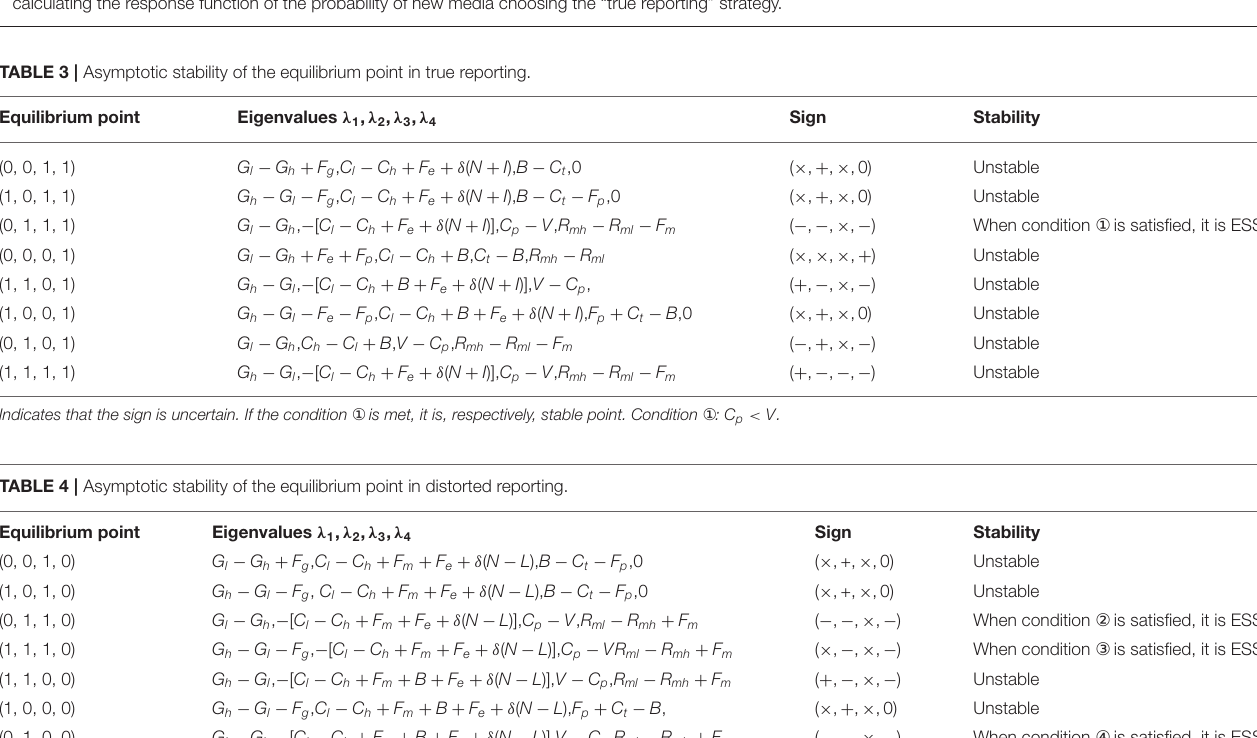
FIGURE 5 | Phase diagram of new media strategic choice. Figure is the phase diagram that shows the evolutionary trend of new media’s strategy obtained by calculating the response function of the probability of new media choosing the “true reporting” strategy.